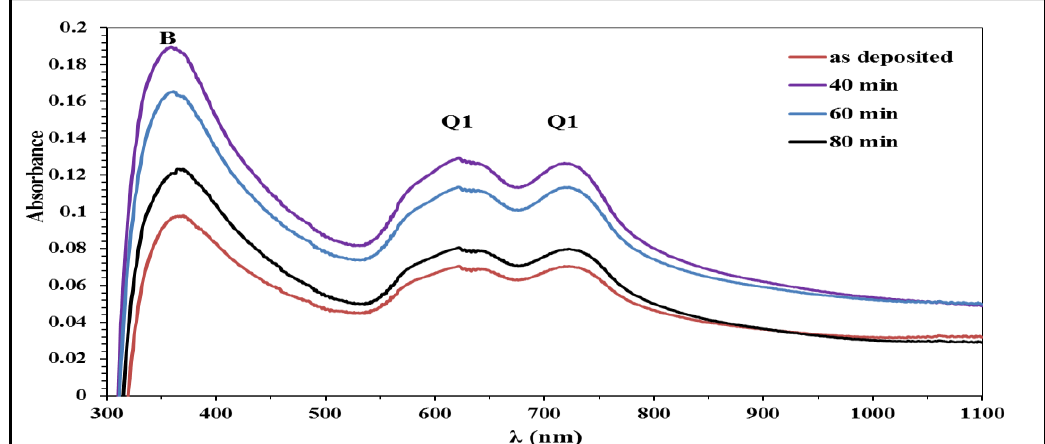
Fig. 7: The absorbance for the blend CuPcTs/PEDOT PSS thin films deposited on glass substrate chemically treated with talwen at different